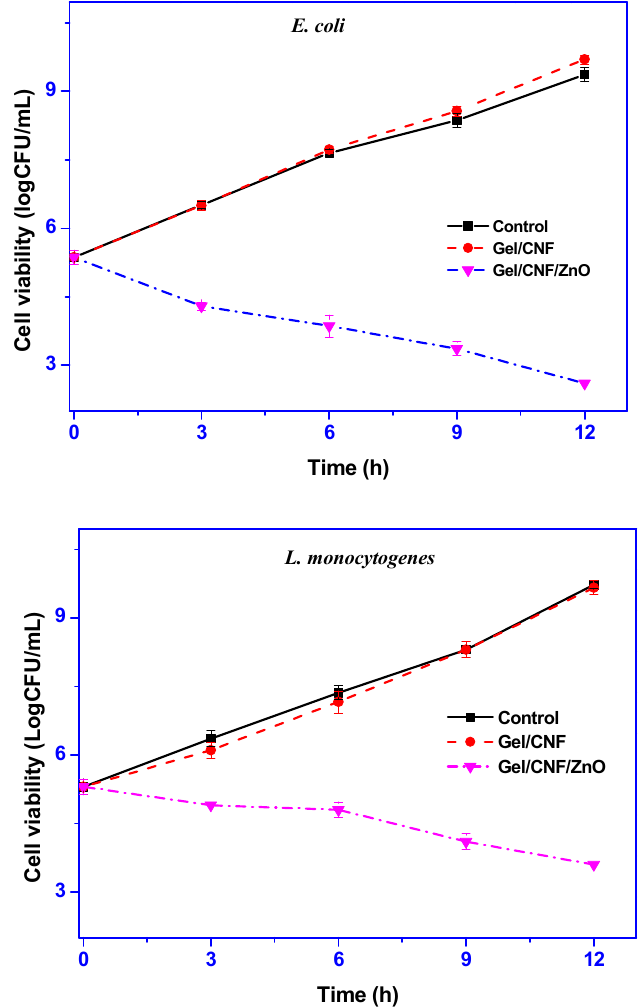
Figure 5. Antimicrobial activity of the gelatin/CNF ‐ based films.